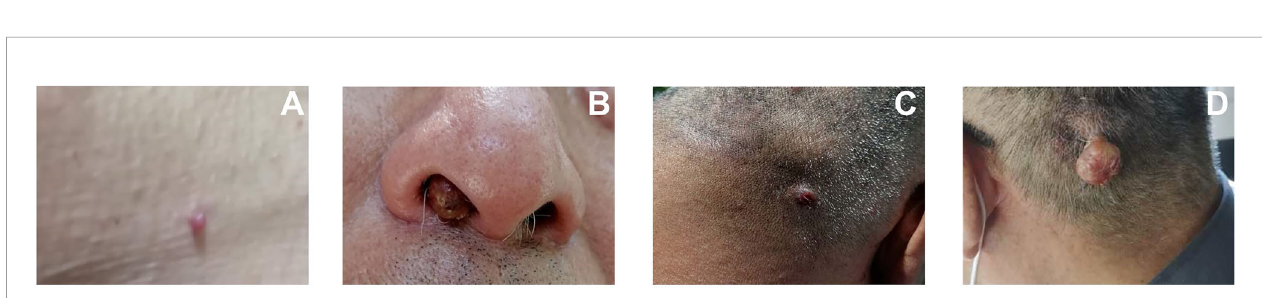
FIGURE 4 | Reactive cutaneous capillary endothelial proliferation. (A) “ Red-nevus-like ” nodule with a diameter of 1 to 2mm on the skin surface of the neck. (B) “ Tumor-like ” nodule with a diameter of >10 mm in the nasal cavity. (C) “ Pearl-like ” nodule with a diameter of 5 mm on the occipital skin surface. (D) The nodule on the left occipital skin surface enlarged to a pedicled “ tumor-like ” nodule with a diameter of >10